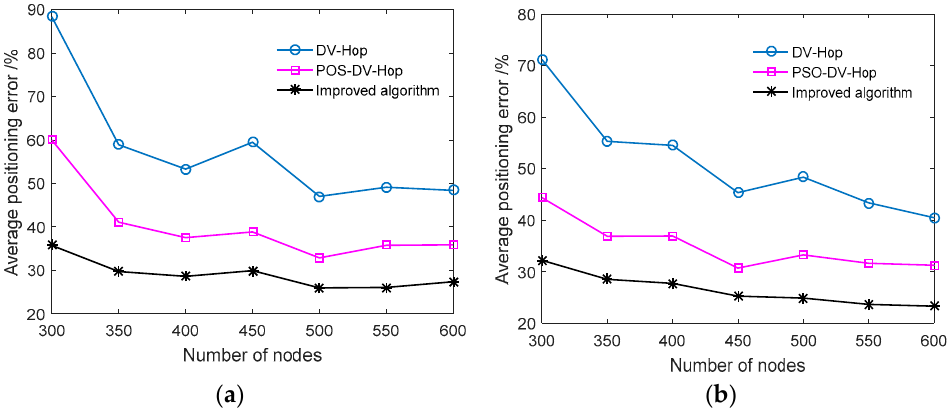
Figure 6. Comparison of average positioning errors of three algorithms for uniform distribution and random distribution: ( a ) average positioning error of uniform distribution of anchor nodes; ( b ) average positioning error under the random distribution of anchor nodes.